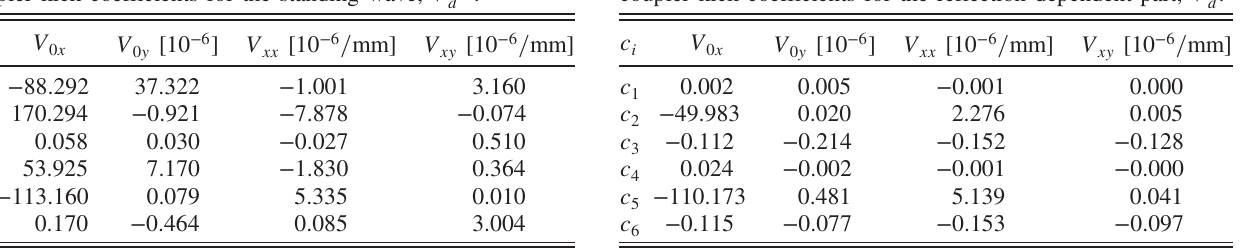
TABLE IV. Fit parameters from Eq. (18) for downstream coupler kick coefficients for the standing wave, V SW d .